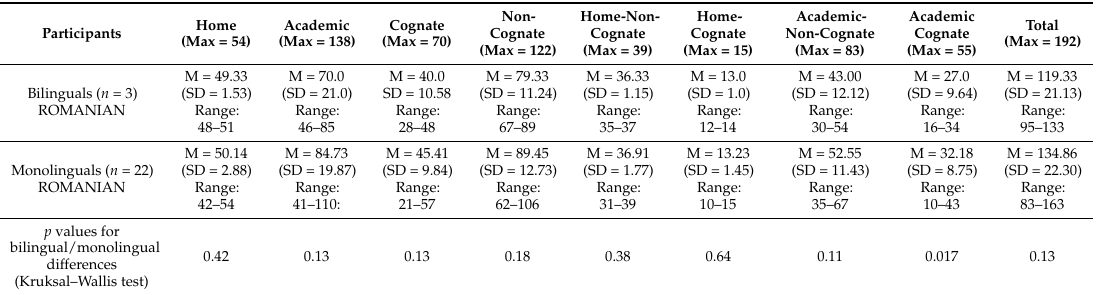
Table 4. Bilingual and monolingual performance at age six on sub-classes of words on the English and Romanian